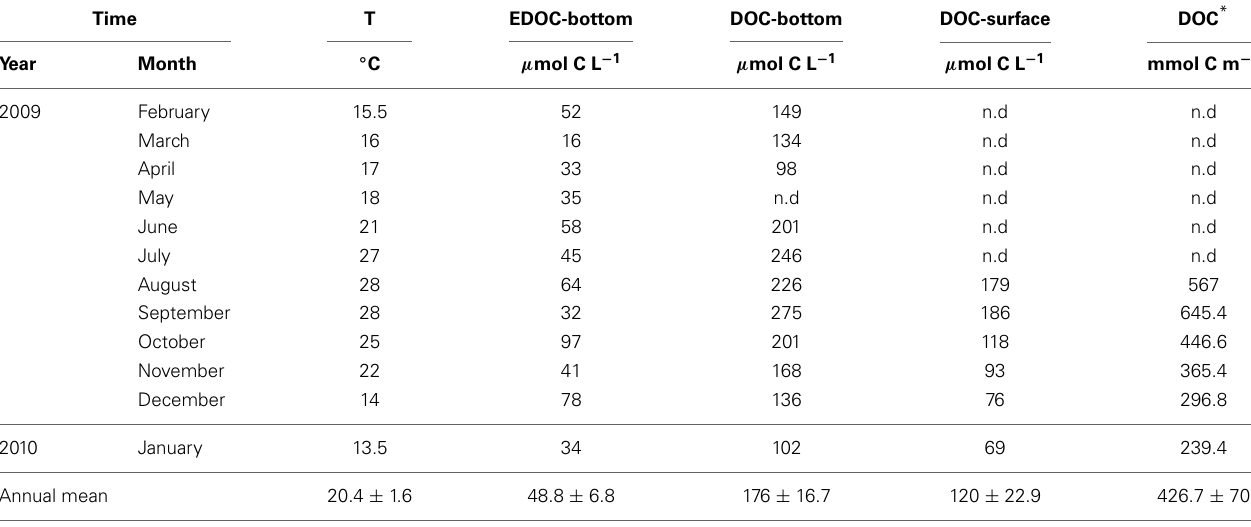
Table 1 | Sea surface temperature, EDOC in bottom waters, and DOC in bottom and surface waters in the bay of